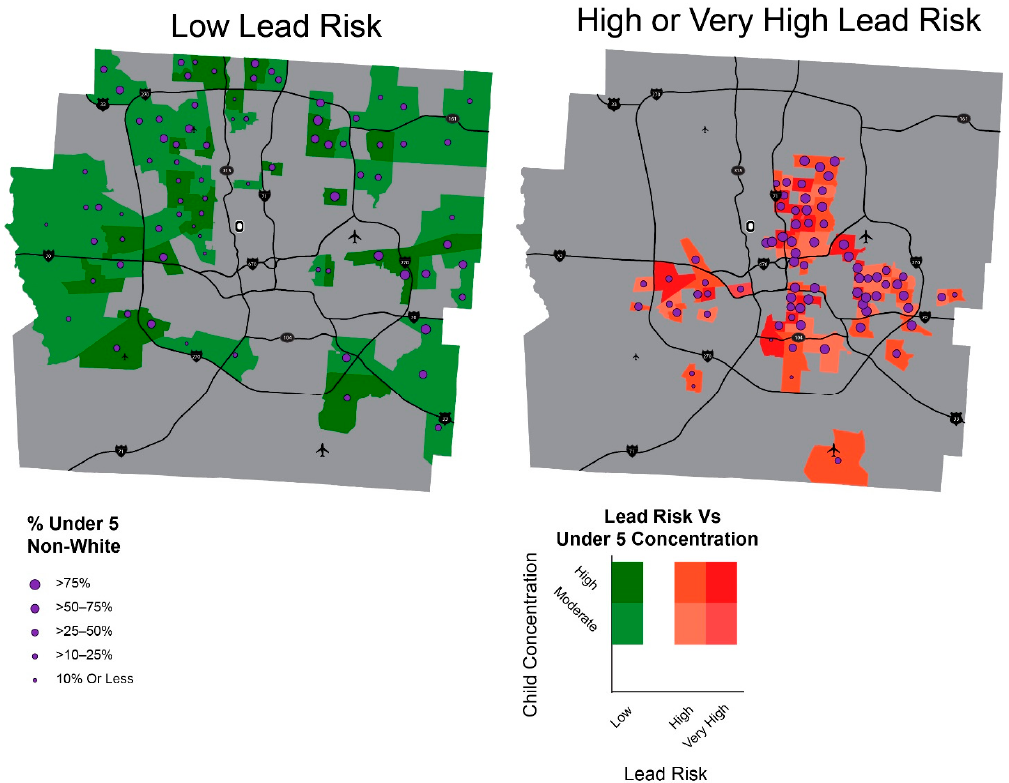
Figure 6 . Lead Risk Areas and Percent of Non ‐ White Children . Figure 6. Lead Risk Areas and Percent of Non-White Racial disparity in lead risk in the county is also depicted in Figure 7 below. Among children under 5, close to two thirds of white children and over 75% of Asian children live in areas of low lead risk, as opposed to 45% of Black children and 37% of Hispanic children that live in areas of high or very high lead risk. The number of Black children in high lead risk areas ( n = 11,484) takes up about half of total number of children under 5 living under higher lead risk levels ( n = 24,486) in the county, meaning one of two children aged 0–5 living under high lead risk areas in the county are Black, while they take up only 27.8% of total children under 5. Figure 7 . Lead risk and children under 5 by race .